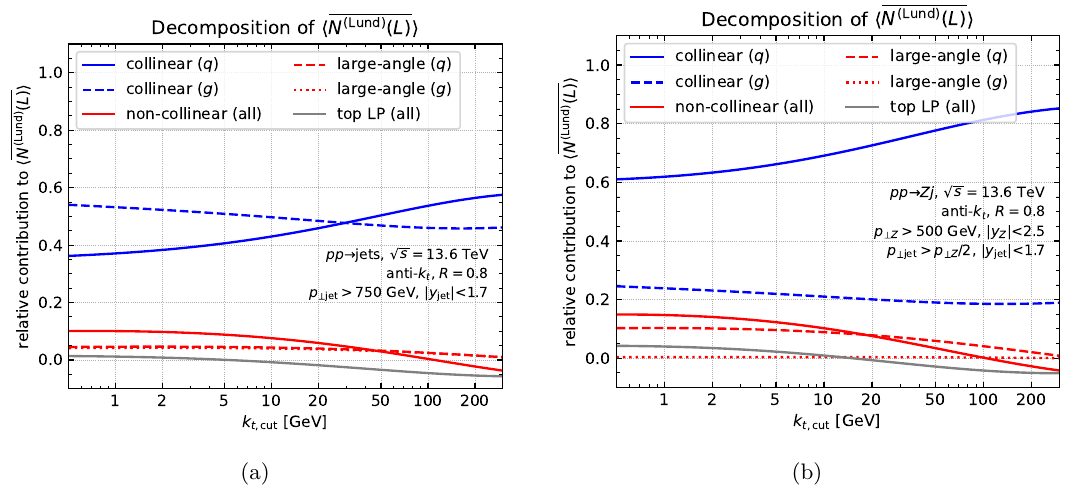
Figure 6 . Relative weight of each term to the total Lund multiplicity at NNDL accuracy for an inclusive sample of jets (left) and Z +jet events (right). We distinguish universal, collinear terms (blue) from those contributions which depend on the event structure, i.e. wide-angle radiation (red) and hard matrix-element corrections